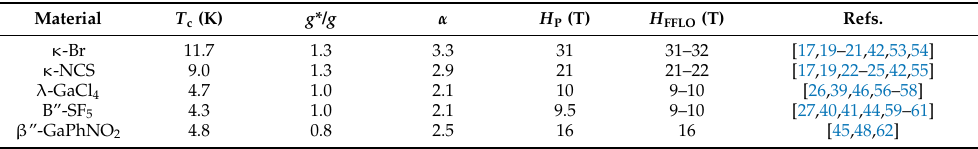
Table 1. Reported H FFLO and calculated H P with parameters characterizing the FFLO state. The abbreviations of the material names are described in the main text. The shown H P is estimated by the Equation (3) and the parameters shown here, which are typical values taking into account sample dependence, etc. For the estimation of the values of g* / g , the Wilson’ ratio R W , calculated by γ and χ P , is also used to compare with g* / g determined by angle-dependent quantum oscillations. The values of α are taken from heat capacity